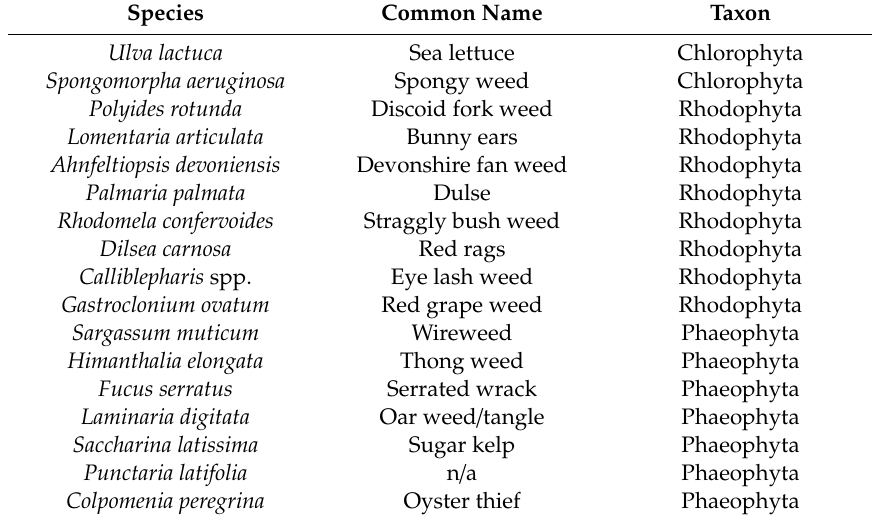
Table 1. Seaweed harvested on the South Devon coast from Broadsands Beach 50 ◦ 24 (cid:48) 24.9” N 3 ◦ 33 (cid:48) 16.2”